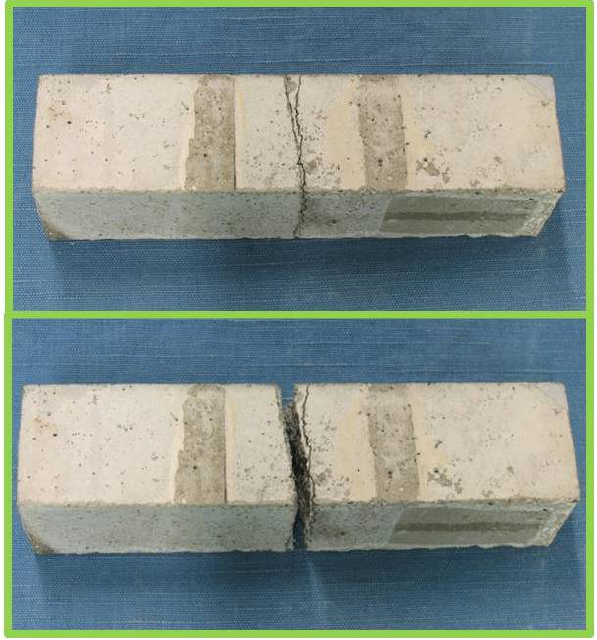
Figure 12. Detail of one of the specimens after the final three-point-bending test, with the creation of a new crack path partially separated from the one generated via the first flexural